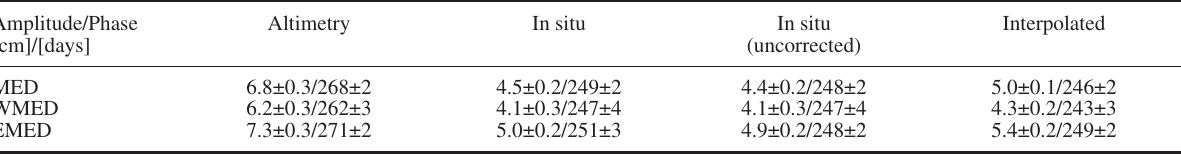
t able 2. – Annual amplitude and phase of spatially averaged time series of the SLA from altimetry and the SSL from in situ profiles (both XBT/MBT bias–corrected and uncorrected) and interpolated data computed over the entire Mediterranean Sea (MED) and the western (WMED) and eastern (EMED) Mediterranean sub-basins.